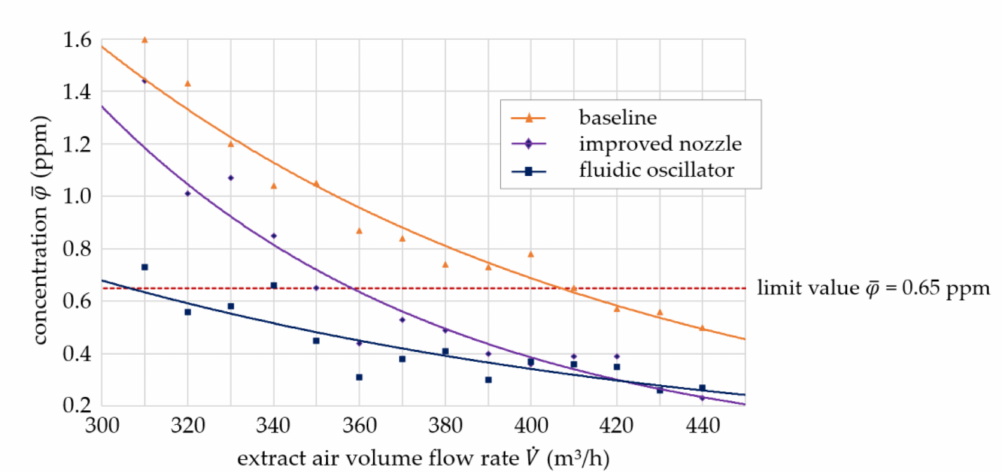
. V in different nozzle